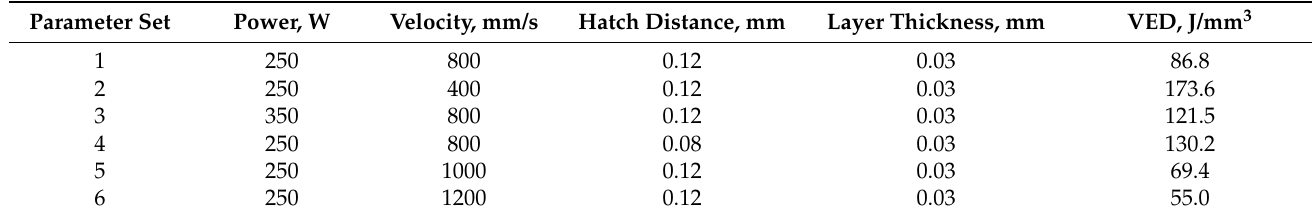
Table 2. Selective laser melting parameters for the preparation of compact samples.